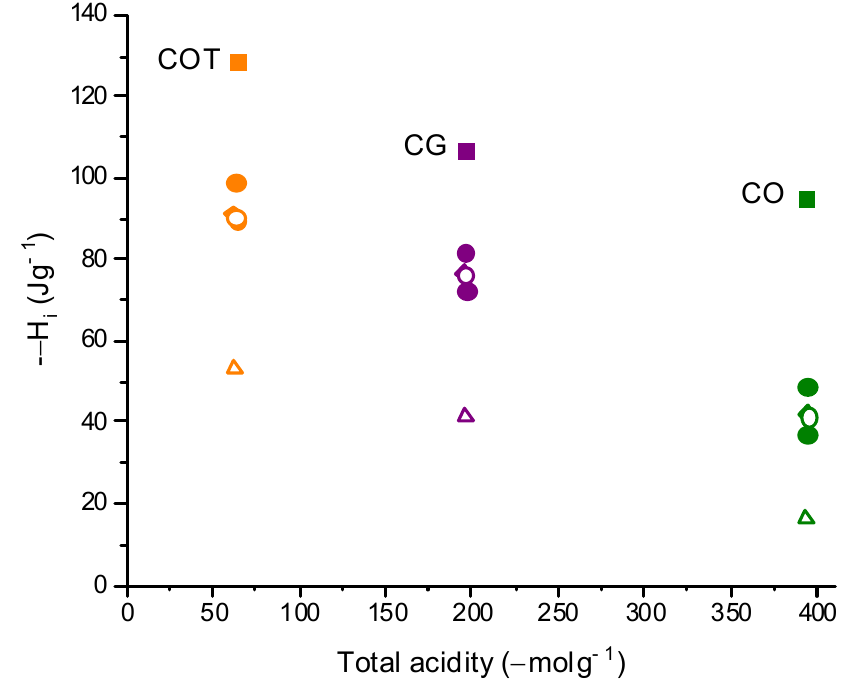
Figure 8. Enthalpies of immersion of CG, CO, and COT in the binary mixtures as a function of the total acidity.